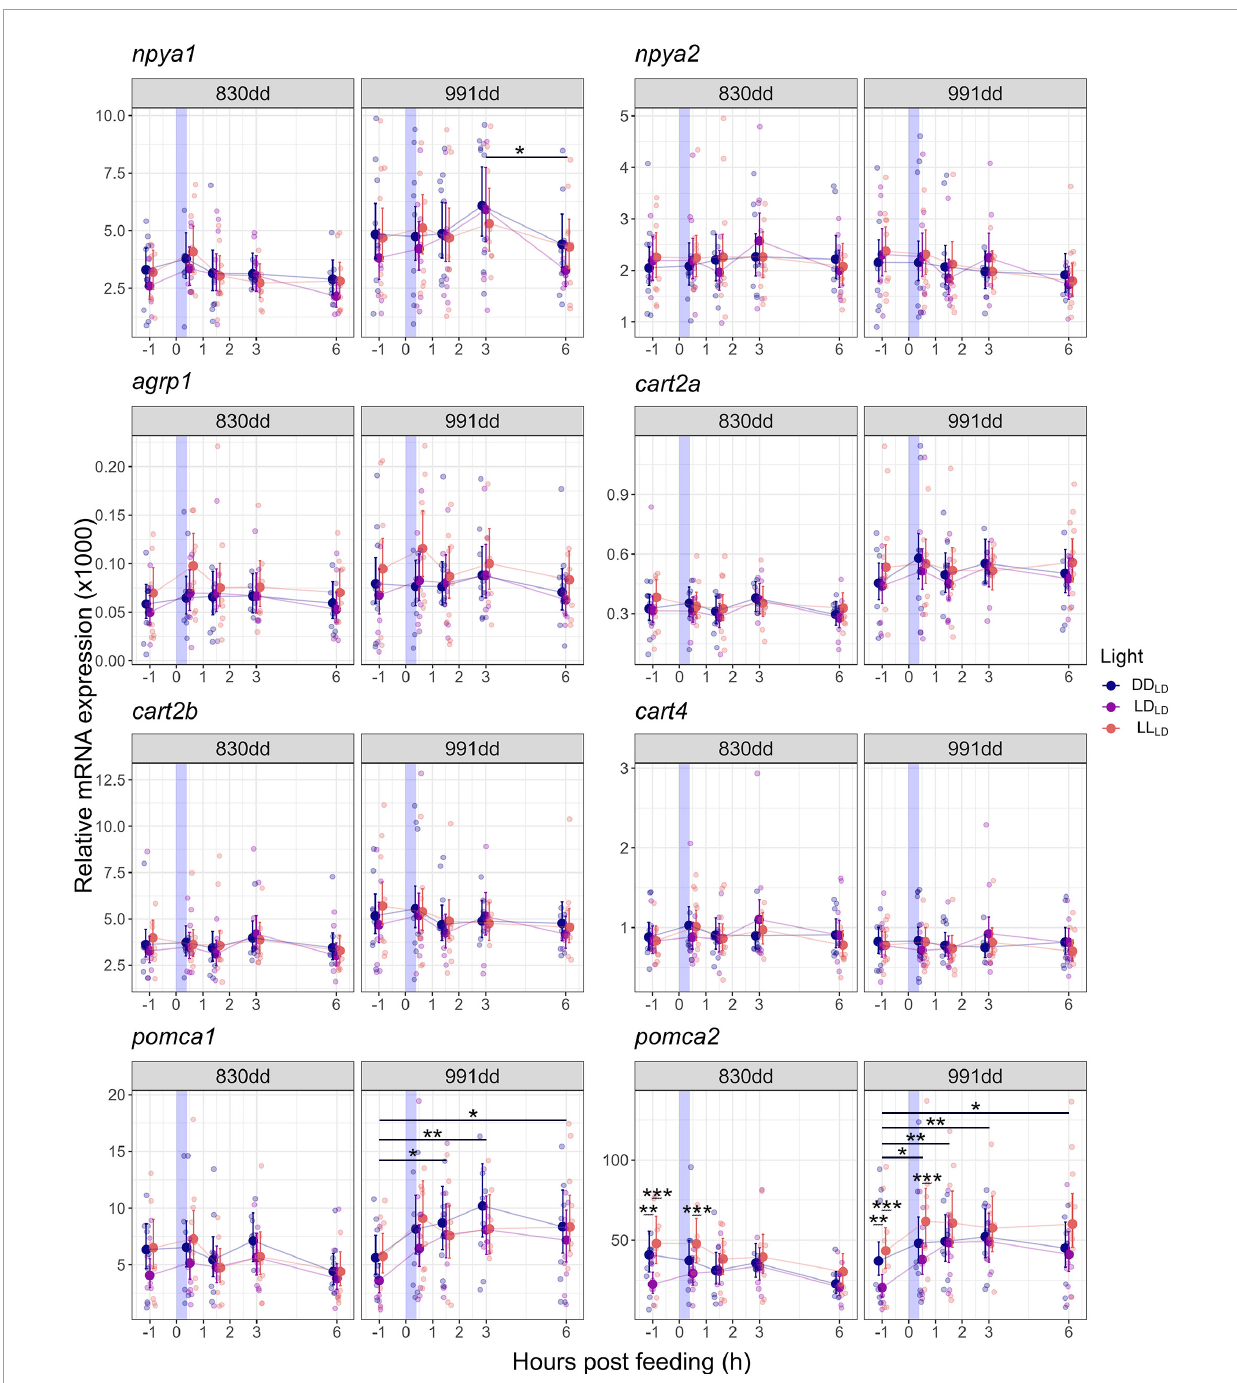
FIGURE4 Model predicted values and raw data of relative mRNA expression of npya1 , npya2 , agrp1 , cart2a , cart2b , cart4 , pomca1, and pomca2 in Atlantic salmon whole brain 1 week (alevins, 830 dd) and 3 weeks (fry, 991 dd) into exogenous feeding in response to a meal and light condition during development. Larger dots and lines indicate model-predicted means and 95% confidence intervals, respectively, for each sampling point and light condition. Smaller, transparent dots represent individual raw data points. Asterisks show the significant level (* p < 0.05, ** p < 0.01, *** p < 0.001). Please refer to Supplementary Table 3 for the number of